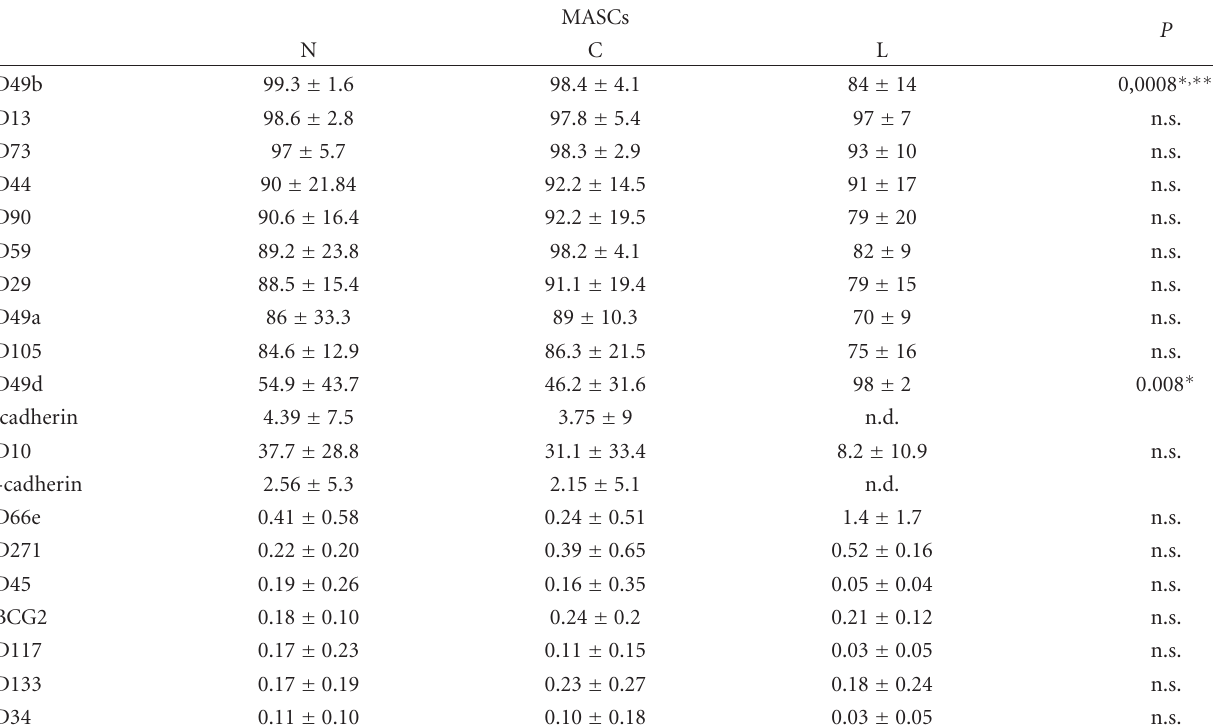
Table 2: Surface immunophenotype of N-, C-, and L-MASCs. Bonferroni post test: ∗ P < 0 . 05 C- versus L-MASCs; ∗∗ P < 0 . 05 N- versus